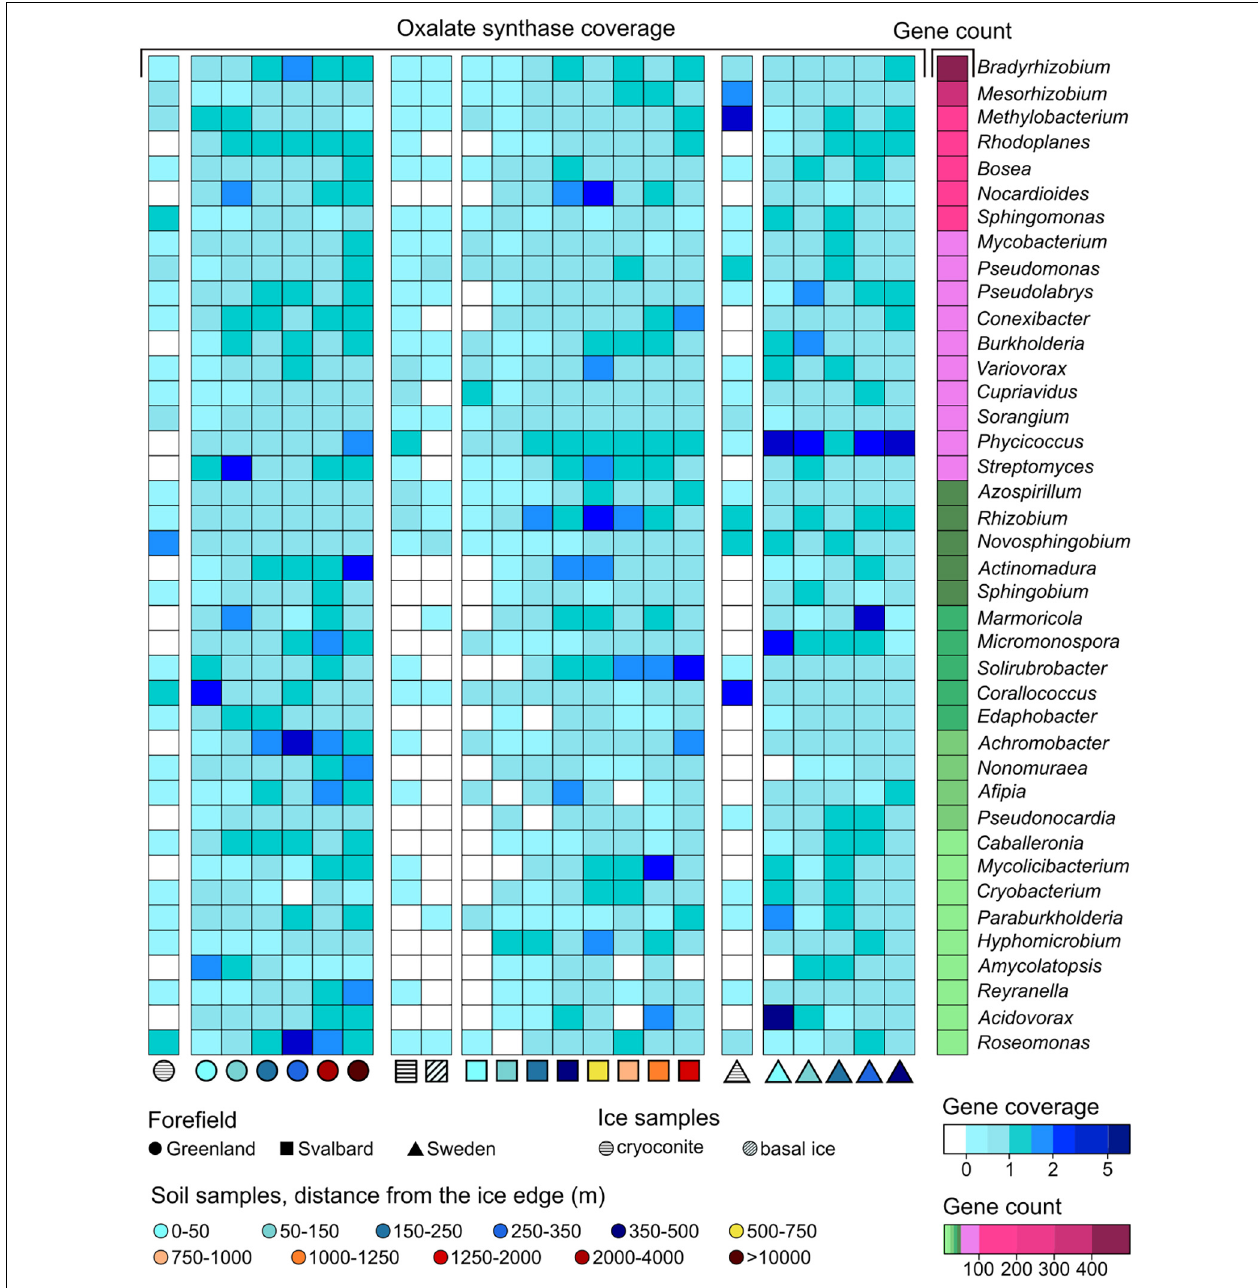
FIGURE 8 | obcA gene (involved in oxalate biosynthesis) trends at the genus level along the microbial successions. Only genera with more than 10 coding regions associated with obcA genes are